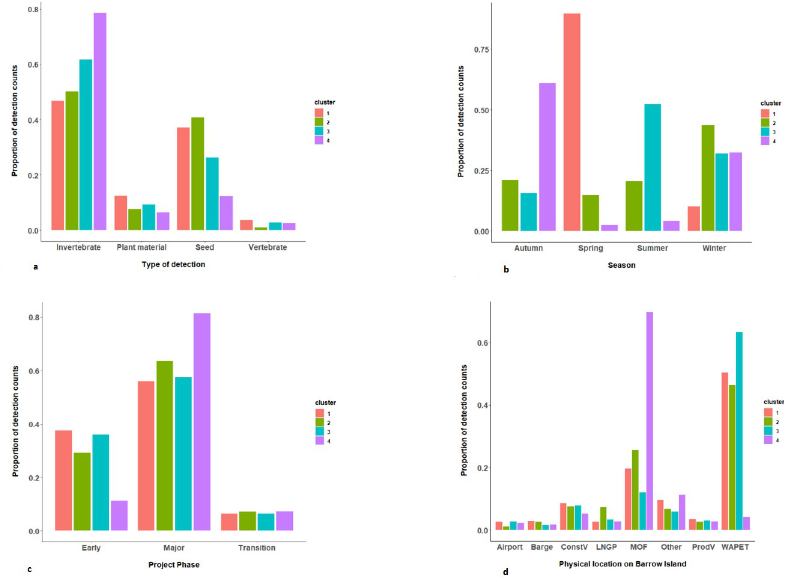
Fig 7. a. Cluster profile by type of detection for the four-component cluster model using data from Barrow Island from 2009 to 2015. b. Cluster profile by seasons for the four-component cluster model using data from Barrow Island from 2009 to 2015. c. Cluster profiles by project phase of construction for the four-component cluster model using data from Barrow Island from 2009 to 2015. d. Cluster profile by physical location of detection event for the four- component cluster model using data from Barrow Island from 2009 to